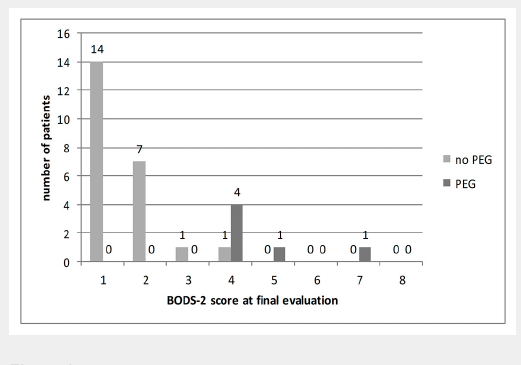
Figure 3 Impairment of deglutition 5 to 7 weeks after stroke. BODS-2 (Bogenhausen-dysphagia-score, part 2) assessed 5–7 weeks after a stroke (final evaluation) in the group with “extended risk of aspiration” (n = 29). PEG indicates individuals with percutaneous endoscopic gastrostomy. Note partitioning into groups (i) BODS-2 <4 and (ii) BODS-2 ≥4. The latter, representing the group of “prolonged impairment of deglutition” (n = 7), had to be predicted from the PHAD score.